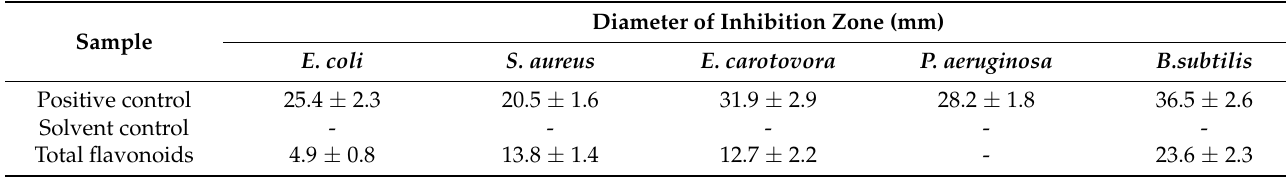
Table 6. Diameter of the inhibition zone of total flavonoid